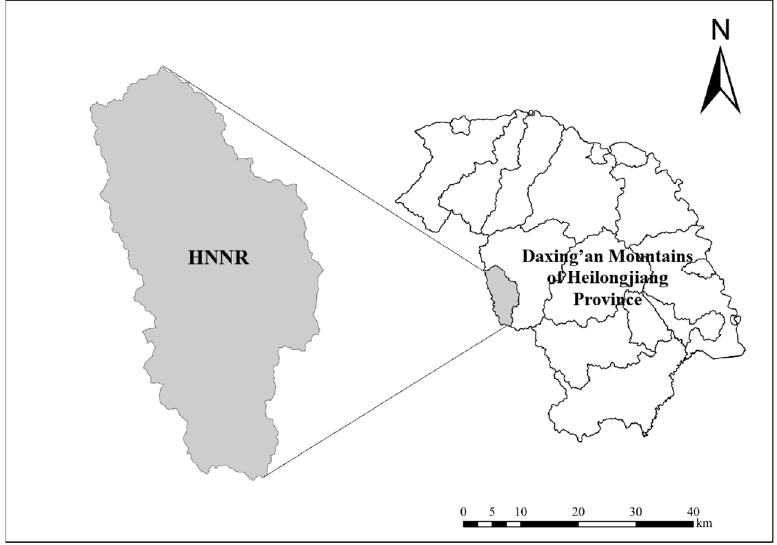
Figure 1. Map of the study